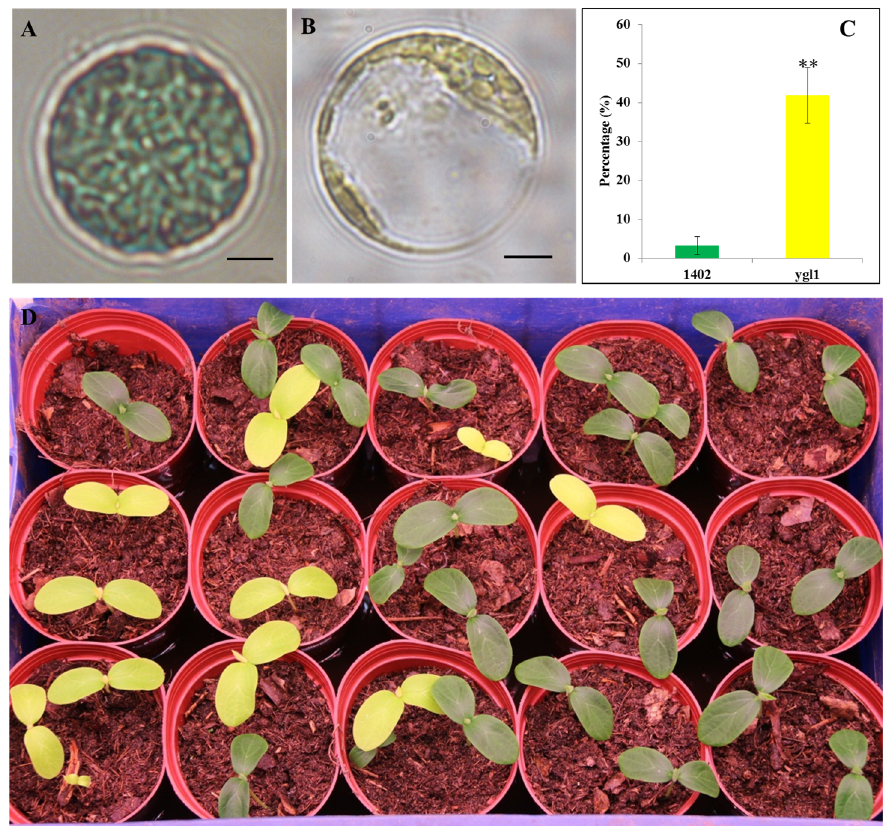
Figure 2. Chloroplast morphology and segregation of F 2 populations in wild type 1402 and ygl1 mutant. ( A , B ) Chloroplast morphology of the protoplast isolated from wild type 1402 and ygl1 mutant leaves. Scale bar = 10 μ m. ( C ) Quantitative proportion of protoplasts with abnormal chloroplast number in cotyledons infiltrated with agrobacterium. For each biological replicate, 50 protoplasts were counted and an abnormal protoplast harbored less than 15 chloroplasts. ** stands for significant difference ( p < 0.01). ( D ) Phenotypic segregation of part F 2 populations in wild type 1402 and ygl1 mutant.